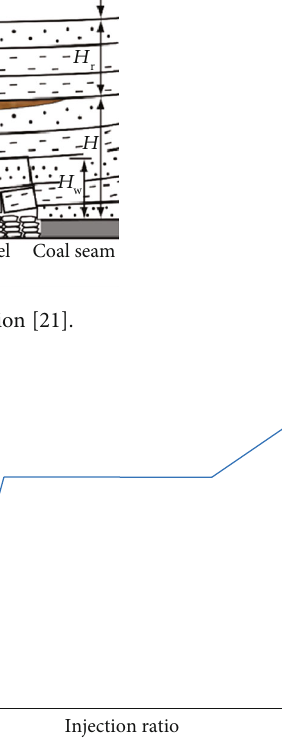
Figure 2: Four stages of borehole injection pressure during longwall overburden grout injection